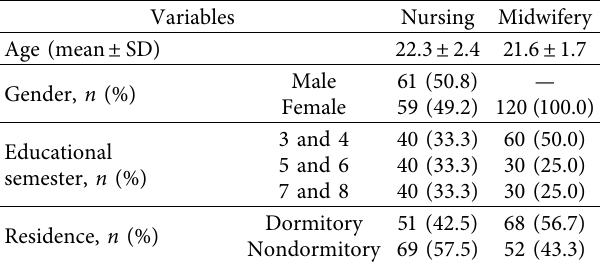
Table 1: Demographic characteristics of participants ( N �